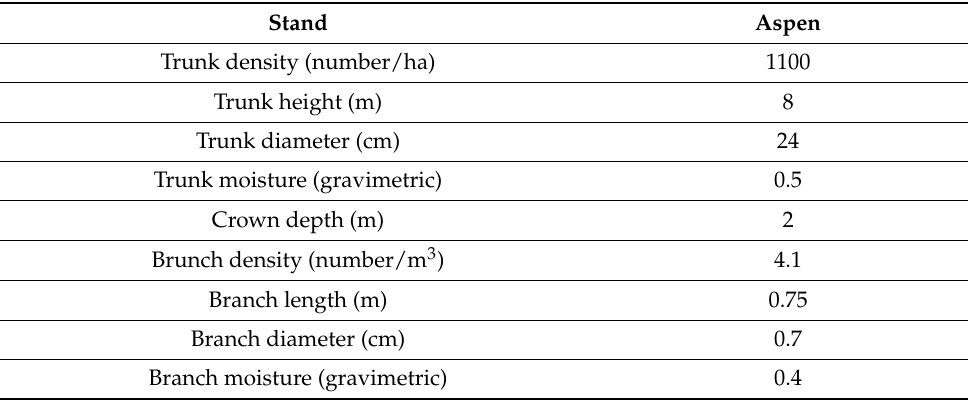
Table 2. Model inputs for the MIMICS